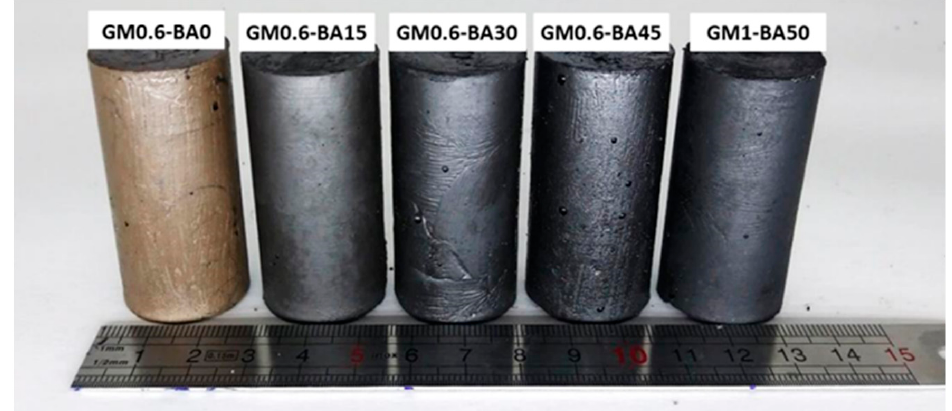
Figure 1. Samples of AA pastes (left to right: GM0.6 ‐ BA0, GM0.6 ‐ BA15, GM0.6 ‐ BA30, GM0.6 ‐ BA45 and GM1 ‐ BA50).